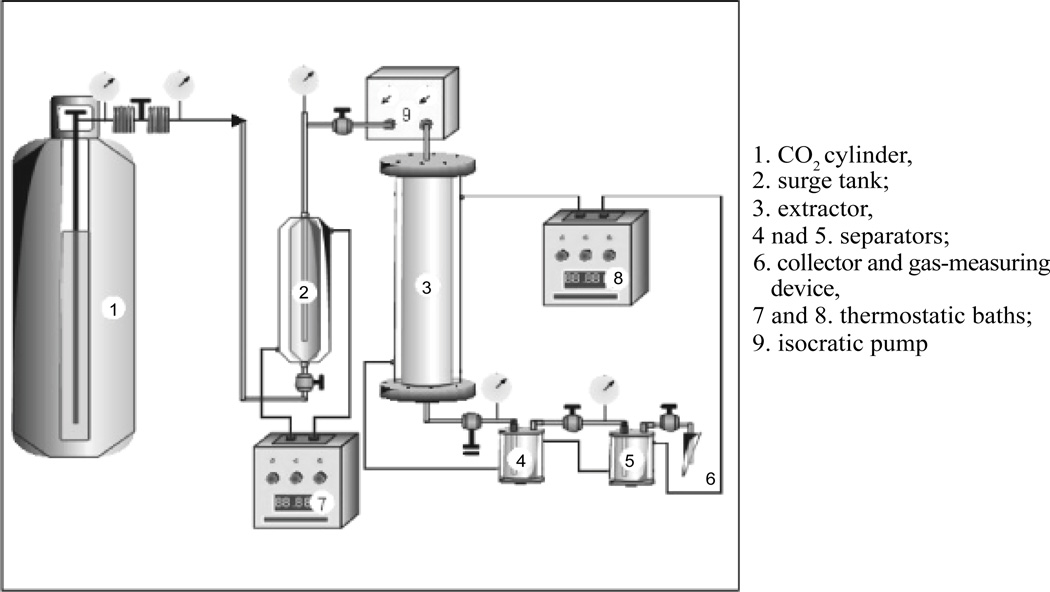
Supercritical fluid extraction (SFE) method [32].